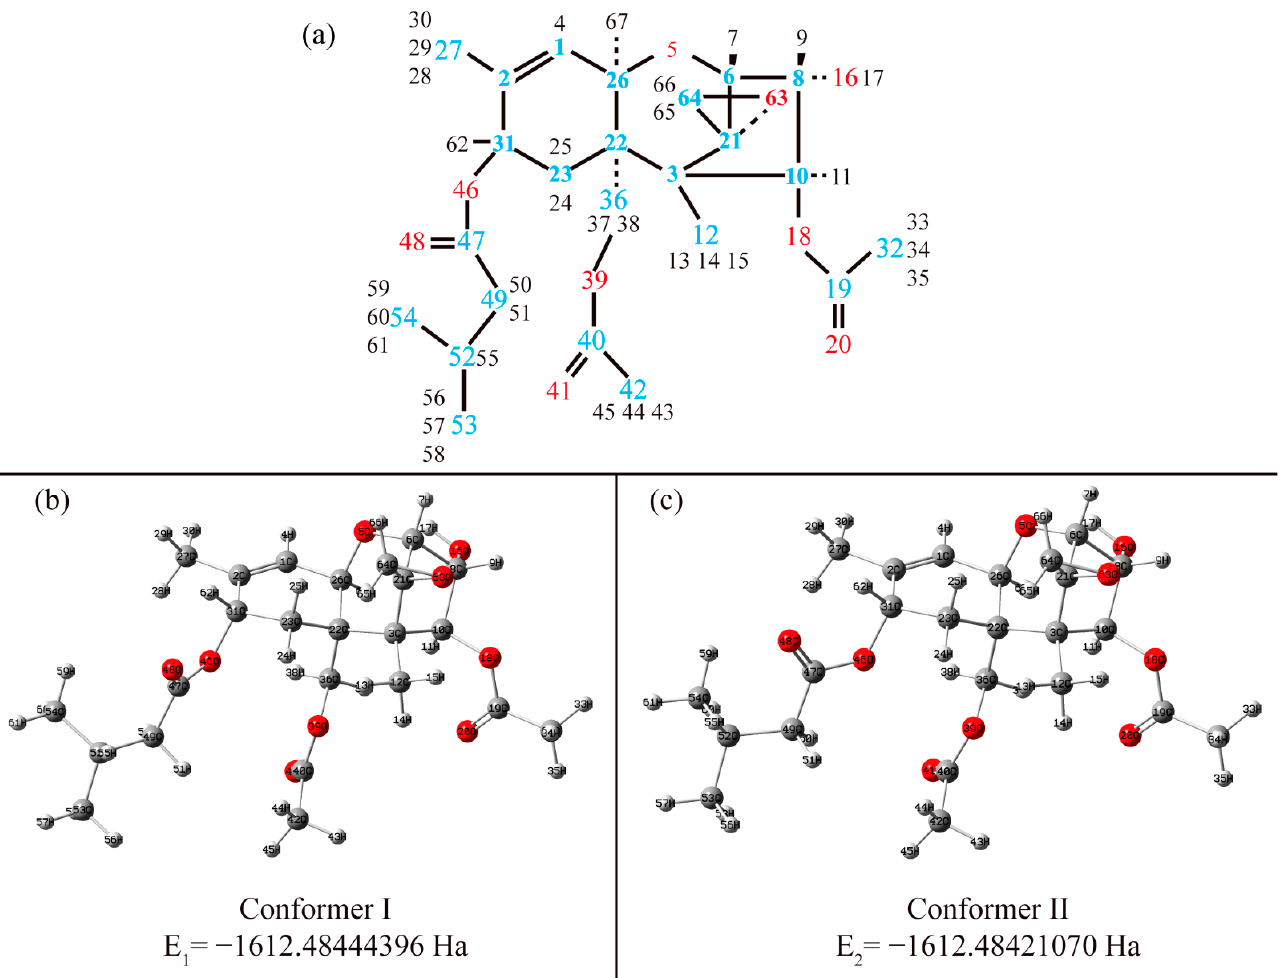
Figure 2. Atomic labels for T-2 molecule (blue, red and black numbers are representation of carbon, oxygen and hydrogen atoms, respectively) ( a ) and stereochemical pictures for conformer I ( b ) and conformer II ( c